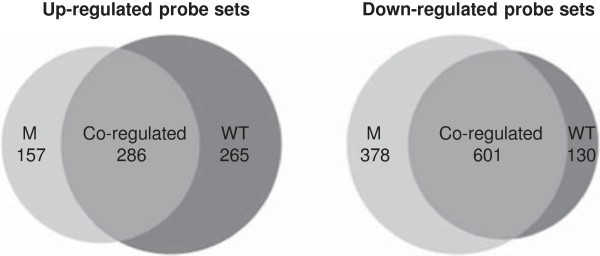
Modulated probe-sets. Venn diagrams show the number of modulated probe sets by the wild-type (WT) and mutant (M) at anthesis under water stress conditions compared with the control.